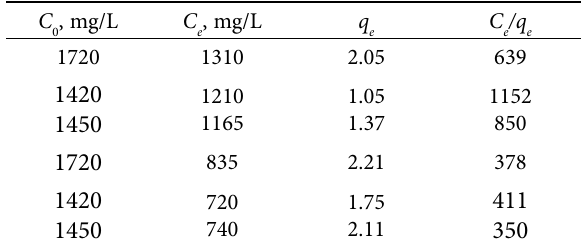
Table 4. Experimental results of equilibrium adsorption